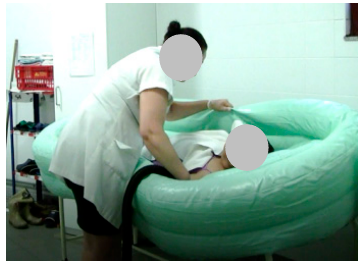
Figure 9. Step 5: The patient is washed on the sides and on the back.